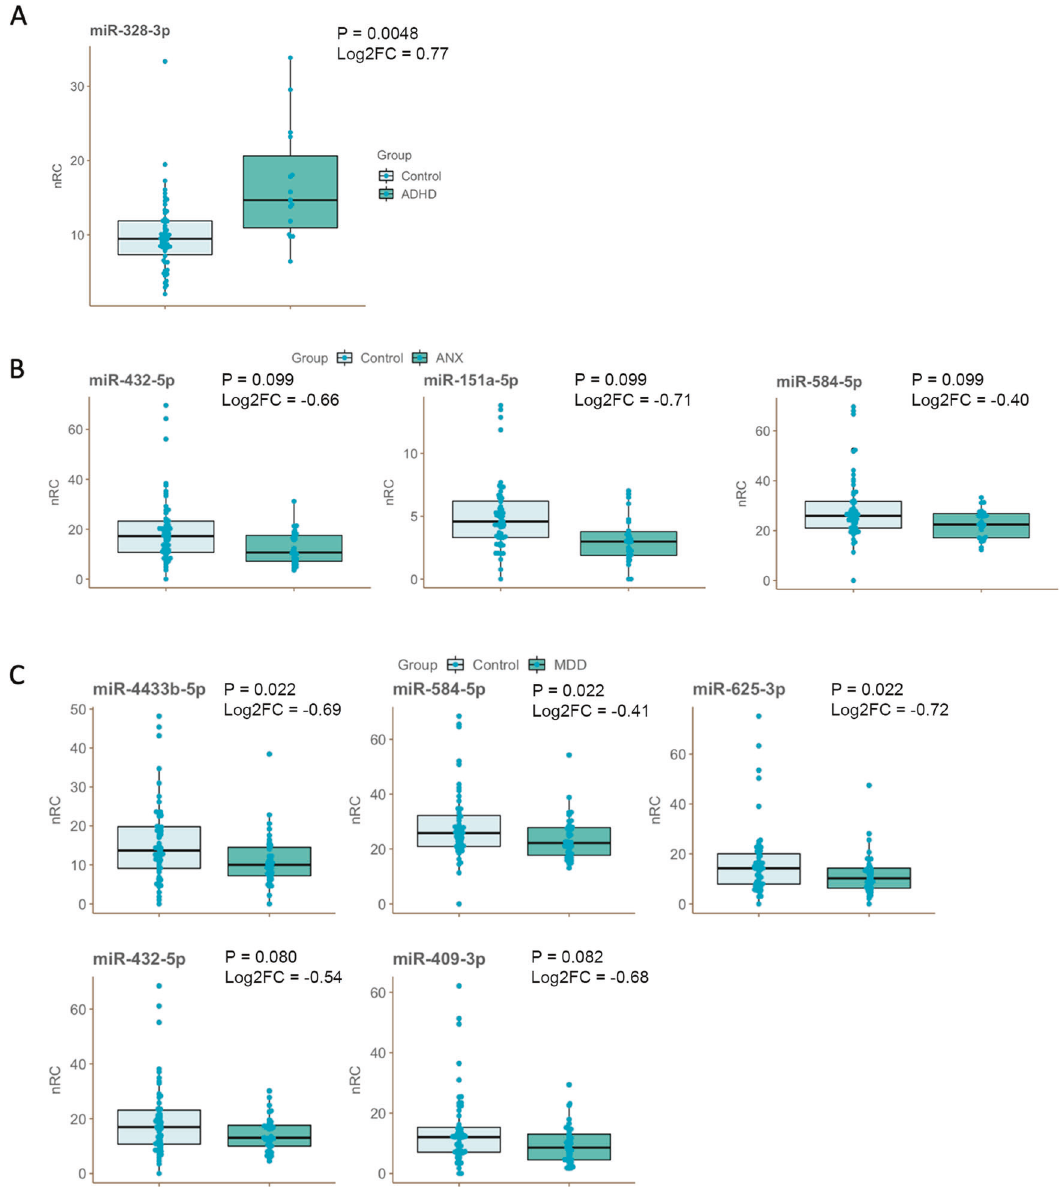
Fig. 2 Normalized counts of differentially expressed miRNA. A miR-328-3p was upregulated in ADHD cases vs. no disorder controls in W1; B miR-432-5p, miR-151a-5p and miR-584-5p were downregulated in ANX cases vs. no disorder controls in W2; C miR-4433b-5p, miR-584-5p, miR-625-3p, miR-432-5p and miR-409-3p were downregulated in MDD cases vs. no disorder controls in W2. nRC = Normalized read counts. Signi fi cance values (FDR-adjusted p value) and effect size estimates (Log2 Fold Change - Log2FC) are shown beside each